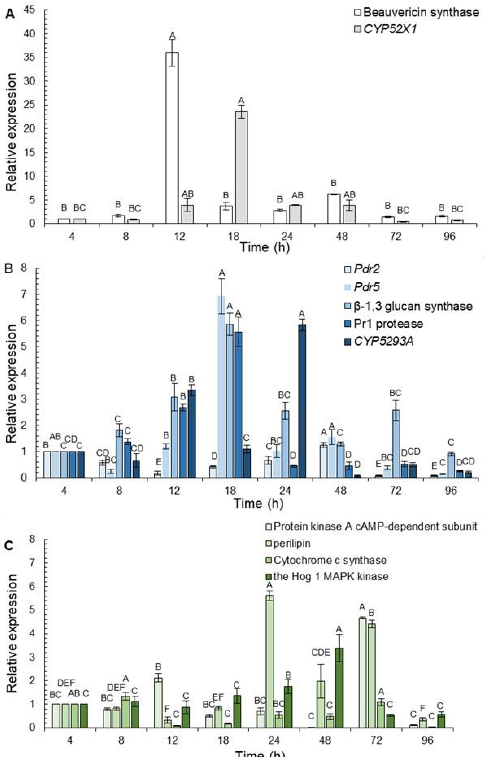
Figure 8. Time course of B. bassiana gene expression during infection of F. occidentalis . The expression of select fungal genes implicated in the infection process was quantified by real-time RT-PCR as detailed in the Materials and Methods section. Means in each column within each gene followed by a different letter indicate significant difference at p < 0.05. Relative gene expression represents the log fold change, 2 −ΔΔCT . ( A ) Expression profiles of B. bassiana beauvericin synthase and CYP52X1 . ( B )